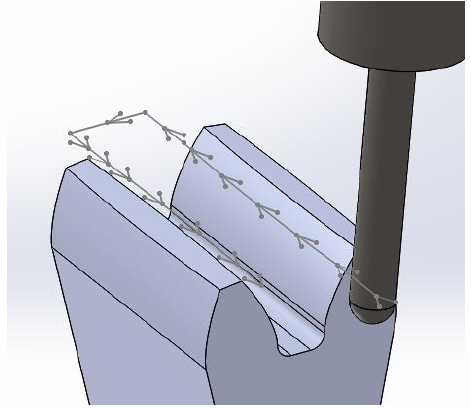
Figure 3. Strategy for machining the gear tooth.